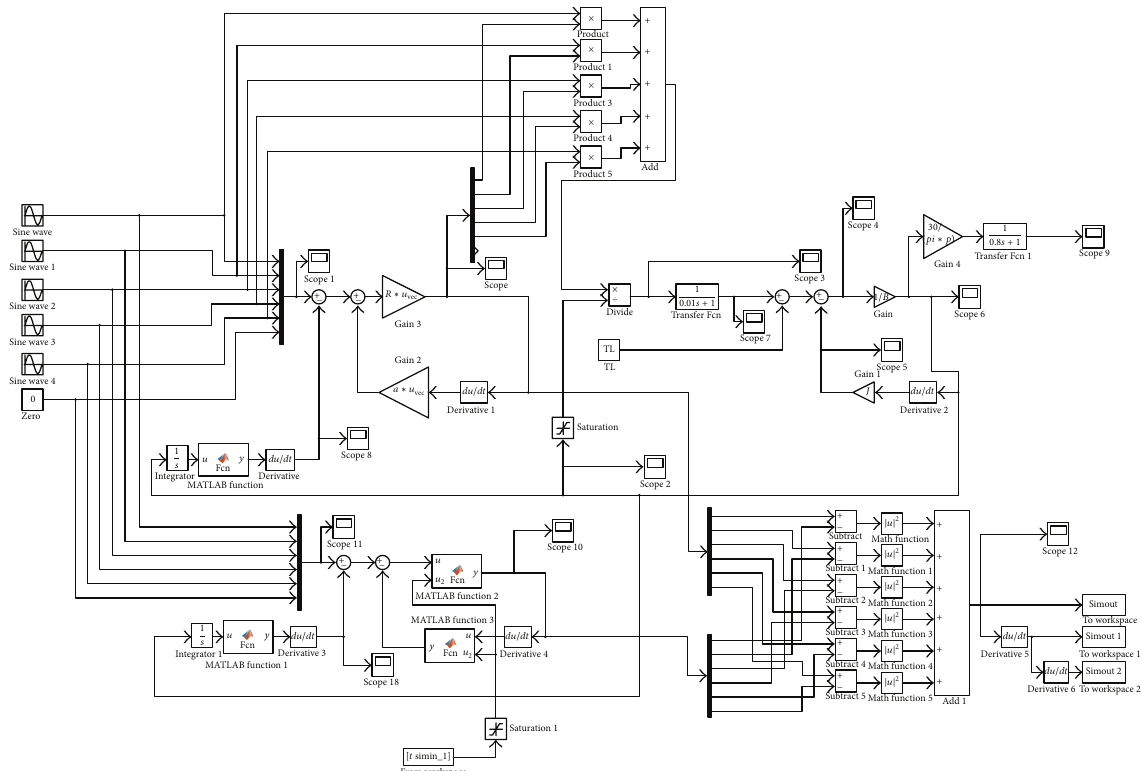
Figure 7: The simulation model of five-phase PMSM for fault parameter identification.